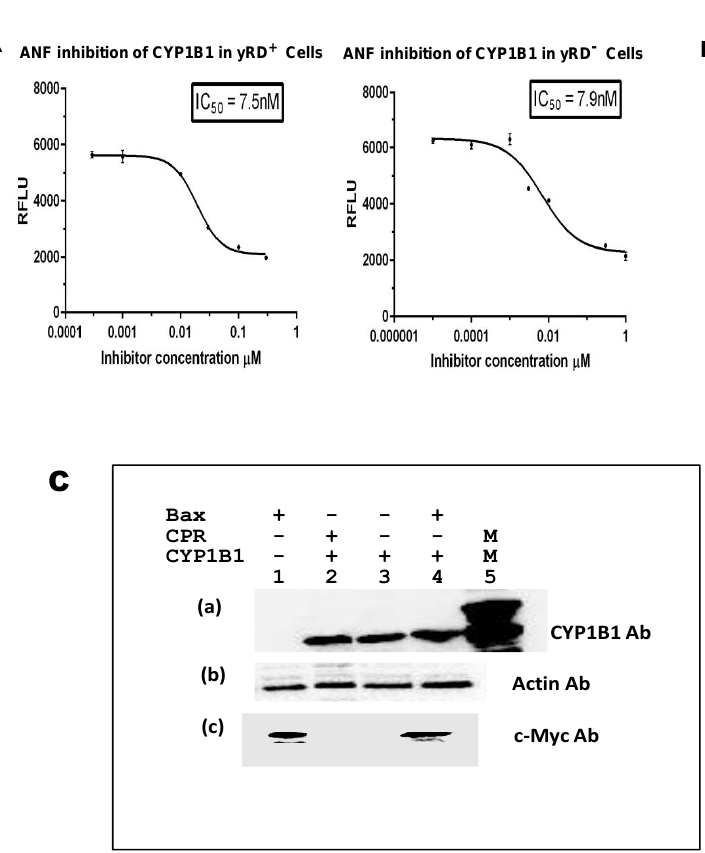
Figure 7. IC 50 of α -naphthoflavone (ANF) for the inhibition of CYP1B1 enzyme expressed within yRD + and yRD − :: Bax cells. ANF’s IC 50 for inhibition of CYP1B1 enzyme that was expressed in live cells. The cells that were used were from strains ( A ) yRD + ( + CPR) and ( B ) yRD − :: Bax (–CPR). CYP1B1 enzyme expression was driven by the ethanol-inducible ADH2 promoter (ADH2p). In yRD − cells, Bax expression was driven by the GAL1 promoter (GAL1p) which is de-repressed in ethanol. Recombinant cells were grown for 18 h in YPD liquid medium containing glucose, allowing for around 6 h of induction and de-repression of ADH2p and GAL1p in ethanol (it takes ~12 h for glucose to be utilized and entirely converted to ethanol). Cells were harvested, washed in PBS-saline. The assay included 1 × 10 7 washed cells and 7-ethoxyresorufin (7-ER) as a substrate. The x -axis represents the values of the concentration of ANF in µ M (ranges from 0.00001 to 3 µ M) were incubated with cells for 10 min and the y -axis relative fluorescence units of the fluorescent product formed. The IC 50 values were calculated using GraphPad Prism software. ANF’s IC 50 for inhibition of CYP1B1 microsomes isolated from a lymphoblastoid cell line is reported to be 5 nM [38]. ( C ) Western Blotting of lysates from yRD + , yRD − , and yRD-:: Bax cells expressing CYP1B1. Yeast cell lysates (5 µ g of total cellular protein for monitoring CYP1B1 and actin; 50 µ g for Bax) fractionated on SDS / PAGE and probed with antibodies to CYP, Bax, and actin proteins after Western blotting. ( a ) Cell lysates probed with a CYP1B1 antibody (Proteintech, 18505-1-AP). Lane 1, yRD − :: GAL1p-Bax (lysate from untransformed cells, which do not contain CYP1B1 episomal plasmid, as negative control). Lanes 2-4: cell lysates from the strains yRD + , yRD − , and yRD − :: GAL1p-Bax transformed with an episomal plasmid that contains a CYP1B1 gene expression cassette under the control of the ADH2 promoter. Lane 2, yRD + :: CYP1B1, lane 3, yRD − :: CYP1B1, lane 4, yRD − :: Bax, CYP1B1, and lane 5, 1.5 pmole of microsomal CYP1B1 (as a positive control; CYP Design Ltd.). ( b ) Lanes 2-4, as in ( a ), probed cell lysates with an actin antibody (Proteintech, 60008-1-Ig). (cLanes 2-4, as in ( a ), probed cell lysates with a c-myc antibody tagged to the human Bax protein (Thermo Scientific, MA